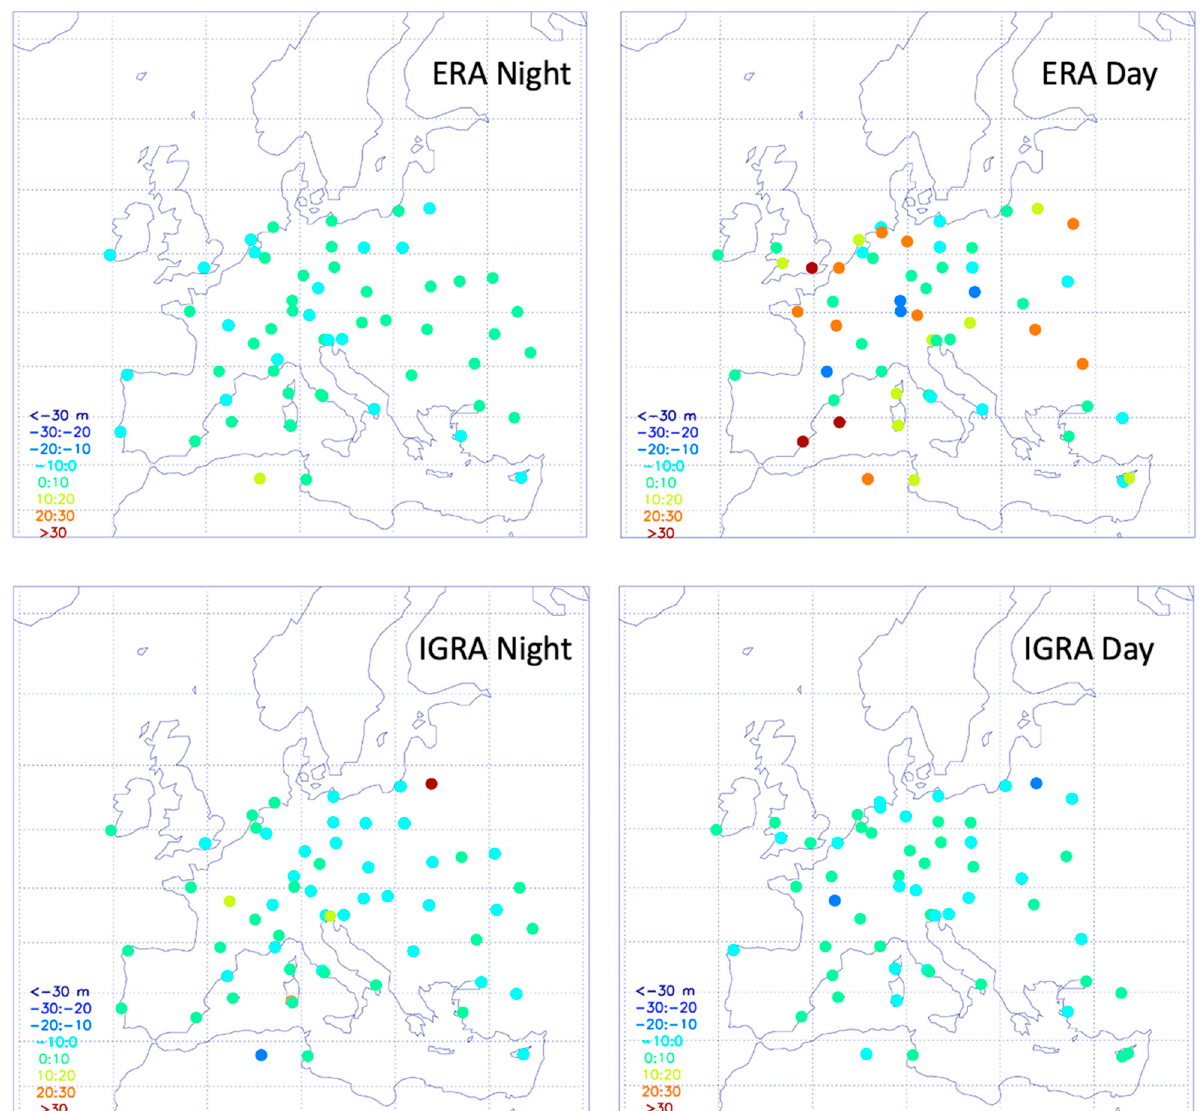
Figure 4. Maps of decadal trends of the nocturnal boundary layer (NBL, left panels) and convective boundary layer (CBL) height (right panels) retrieved from ERA5 (upper panels) and IGRA (lower panels) in the period 1978–2018. Color legend is reported in the bottom left corner of each panel. Dots are representative of the location of the European Union (EU) mid-latitudes radiosounding stations with a data completeness larger then 75%.